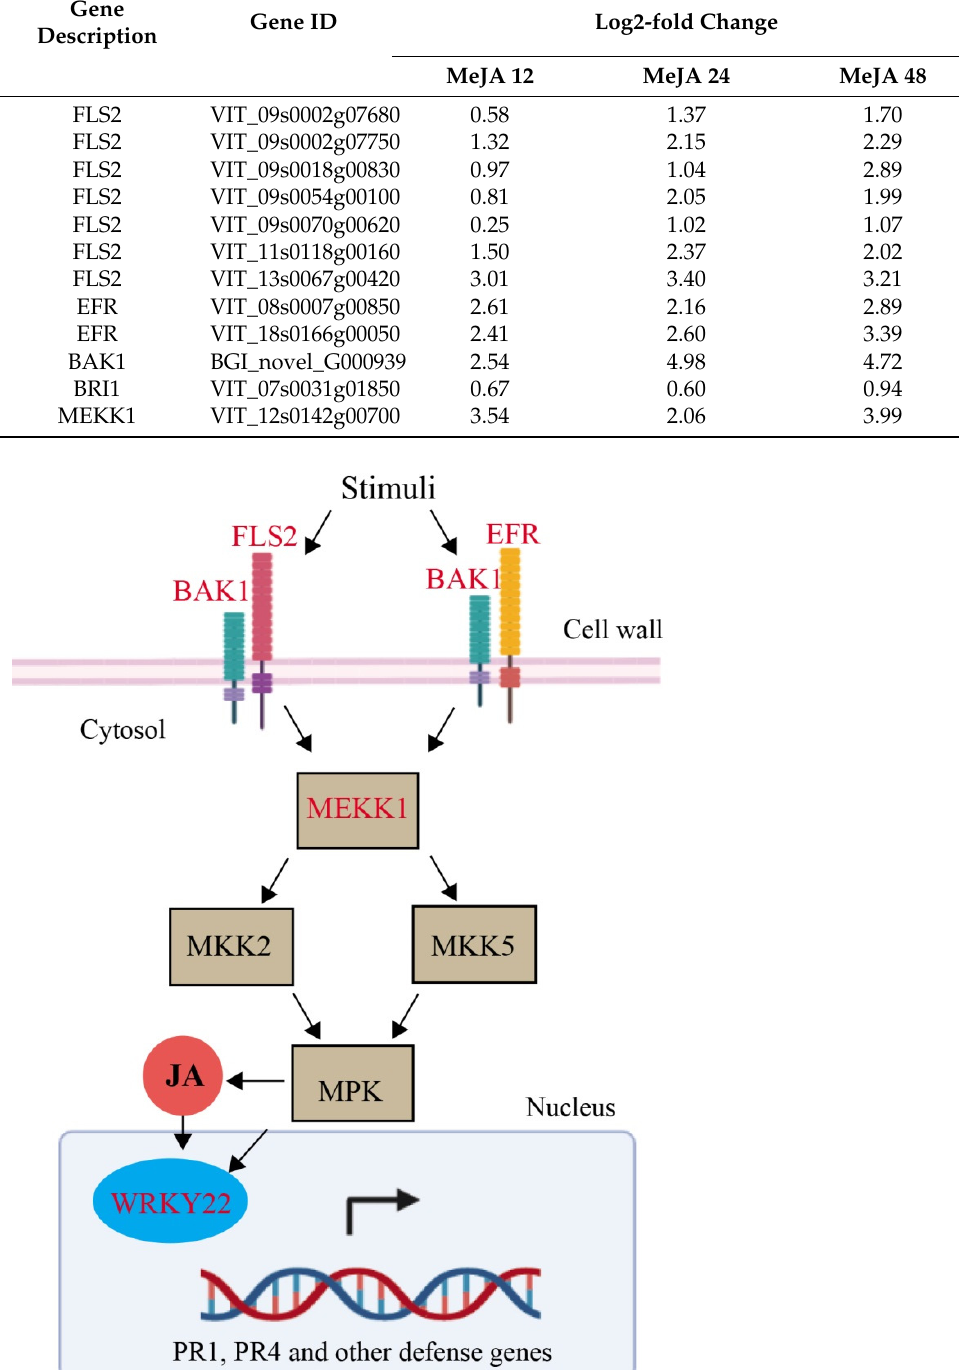
Figure 3. MAPK-WRKY pathways in response to MeJA. The diagram of MAPK-WRKY pathways. The abbreviations for the enzymes; Brassinosteroid (BR) insensitive1 (BRI1), FLAGELLIN-SENSITIVE 2, BRI1-associated kinase 1 (BAK1) (FLS2), Mitogen-activated protein kinase kinase kinsase (MEkK1), Pathogenesis related gene ‐ 1.